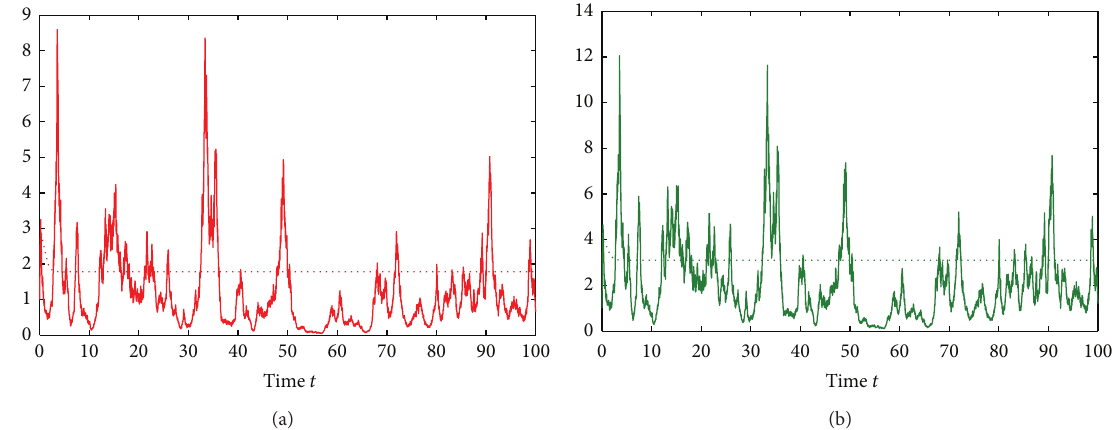
Figure 3: Computer simulation of paths 𝐼 1 (𝑡) , 𝐼 2 (𝑡) for the system (18) and its corresponding deterministic model, using the EM method with step size 0.001, with initial values 𝐼 1 (0) = 1 , 𝐼 2 (0) = 1 . The full line expresses stochastic model’s simulation, and the dotted line expresses the related deterministic